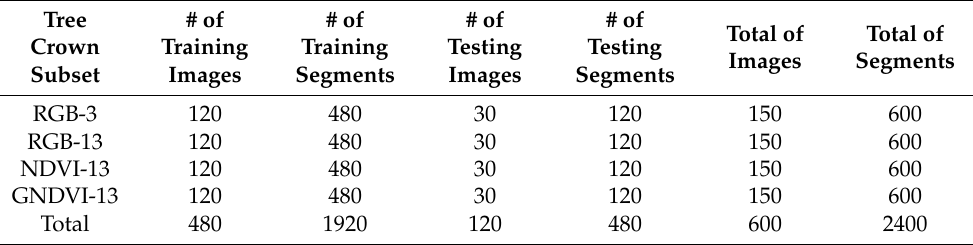
Table 1. A brief description of the number of image patches and segments in the four subsets of the Olive Tree Crown Segmentation in the OTCSS-dataset: RGB-3 cm/pixel, RGB-13 cm/pixel, NDVI-13 cm/pixel, and GNDVI-13 cm/pixel. RGB: Red, Green, Blue; NDVI: normalized difference vegetation index; GNDVI: green normalized difference vegetation